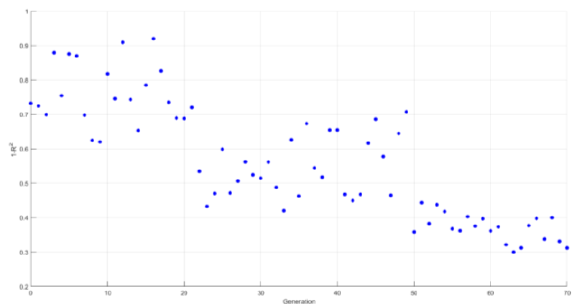
Figure 4. Converging the GA to optimize the SVR meta- parameters